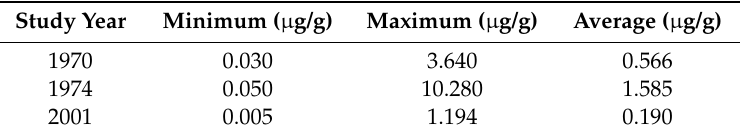
Table 1. Mercury sample summary information for each study year.